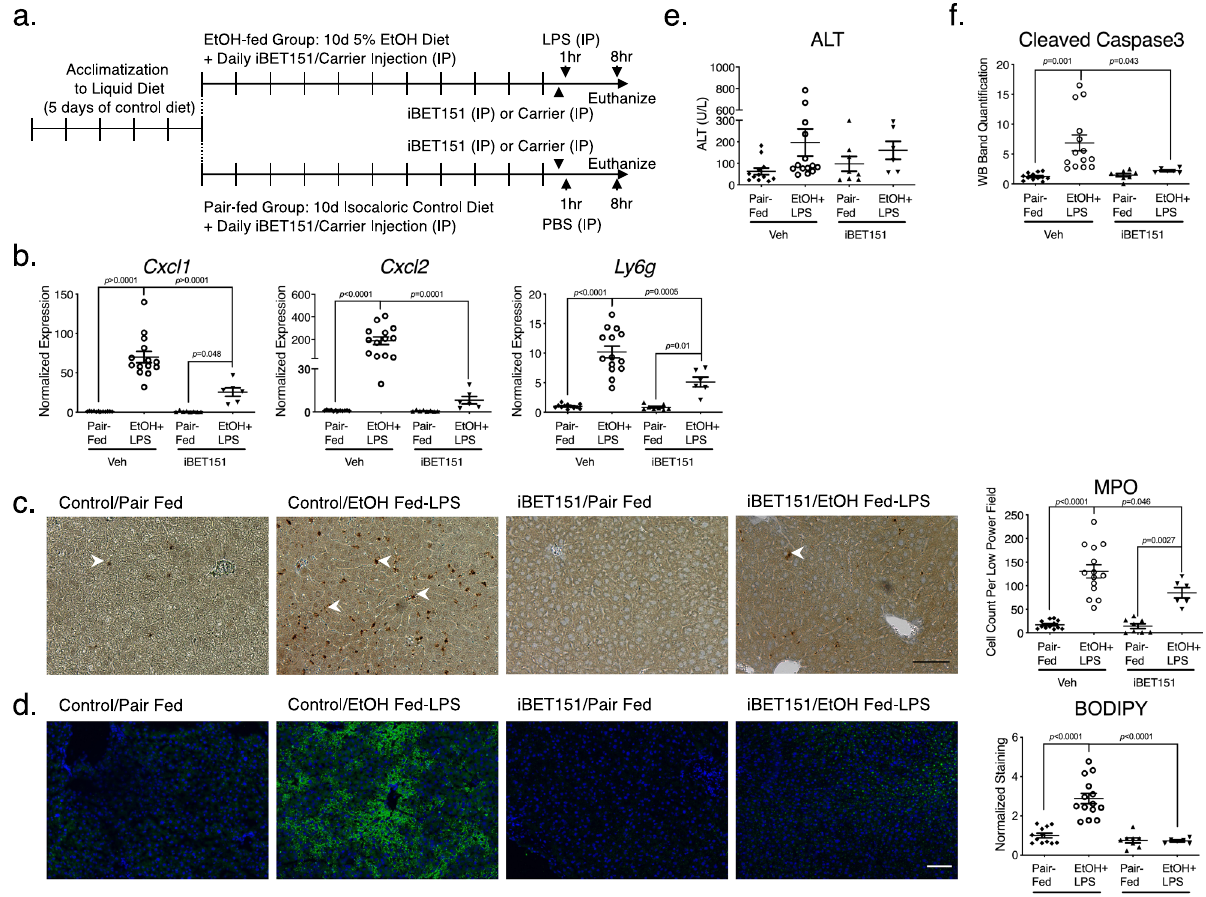
Fig. 6 Bromodomain inhibitor iBET151 attenuates liver CXCL production and neutrophil in fi ltration in a murine alcohol feeding/LPS model. a Schematic of alcohol feeding protocol. Mice were fed a 5% alcohol diet or a pair-fed control diet for 10 days. A subset of mice also received IP injection of the iBET151 compound. Alcohol-fed mice also received IP injection of LPS on day 11, 8 h before sacri fi ce ( n = 12 pair-fed/Veh, n = 14 EtOH + LPS/Veh, n = 8 Pair-fed/ iBET151, n = 6 EtOH + LPS/iBET151, same n for remaining panels of this fi gure). b qPCRs demonstrated CXCL chemokine and neutrophil marker Ly6g elevation with alcohol/LPS treatment. This response was attenuated by iBET151 injections. Expression levels were normalized to the average expression of pair-fed control mice. c IHC for MPO (neutrophil marker) is shown, with a number of neutrophils per low power fi eld on the y-axis. The experiment was repeated with similar results. Scale bar = 100 μ m. d Frozen section of mouse liver was stained with BODIPY 493/503 (green) and DAPI was used to stain nuclei (blue). The experiment was repeated with similar results. Scale bar = 100 μ m. e No statistical difference was noted in serum ALT levels among groups. f Quanti fi cation of Western Blotting of cleaved caspase3 showed increased cleaved caspase 3 in livers of alcohol-fed/LPS mice and attenuated by iBET151 injection. For all analysis, two-way ANOVA was performed on normalized expression values for qPCRs, cell counts for IHC staining, normalized quanti fi cation of BODIPY 493/503 staining, ALT values, or quanti fi cation of WB bands with post hoc Tukey ’ s multiple comparison correction. Data represented as mean ±